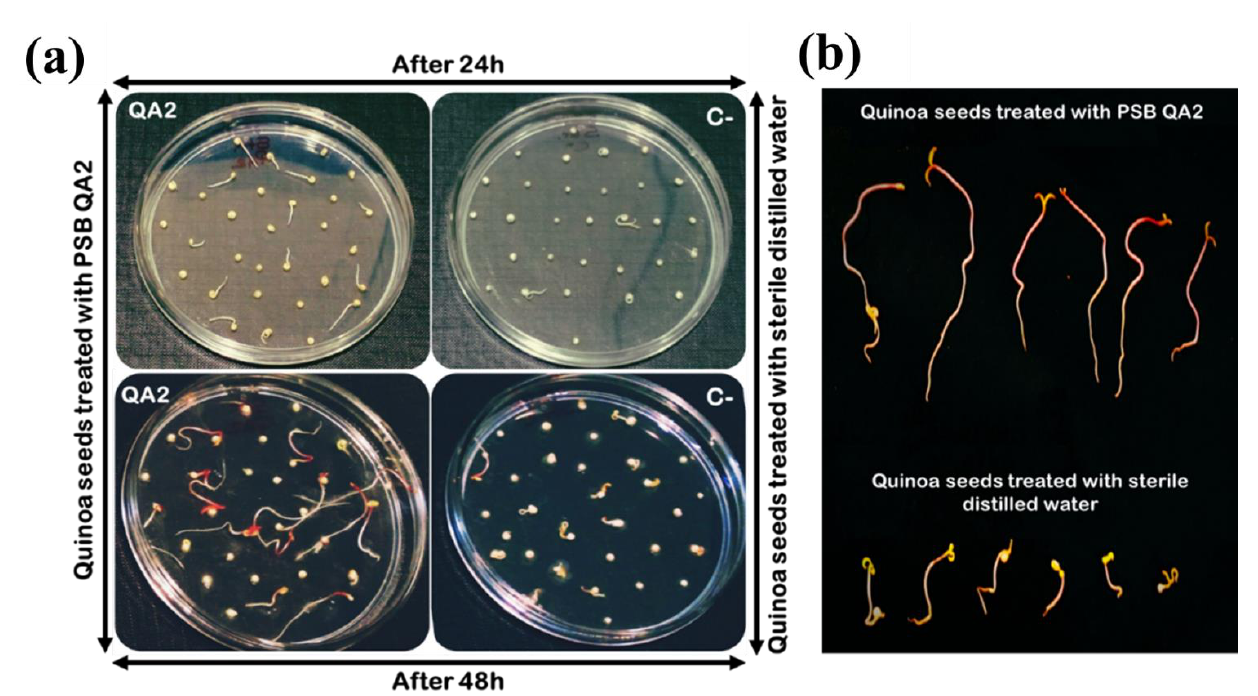
Figure 5. Effect of B. velezensis QA2 strain on early quinoa seed germination and seedlings. ( a ) Ger- mination rates were monitored after 24 and 48 h of incubation at 25 °C. ( b ) Germinated seeds were maintained at room temperature for another 3 days and the total length of seedlings was measured at day 5.